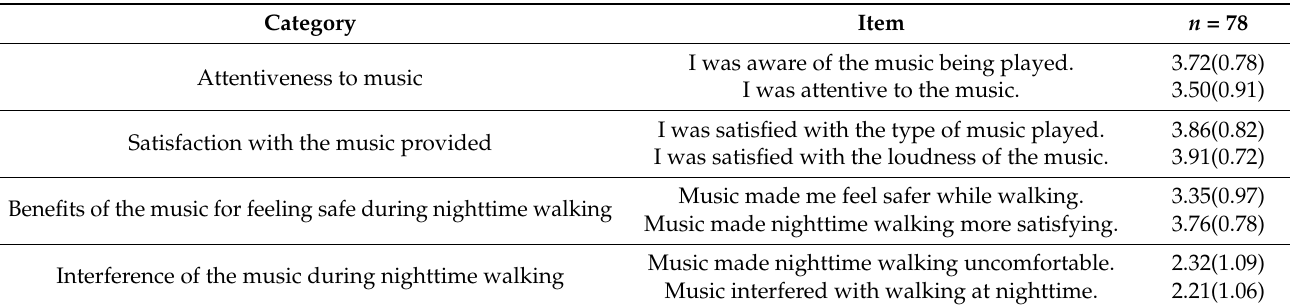
Table 6. Participants’ perceptions of the music listened to during nighttime walking.